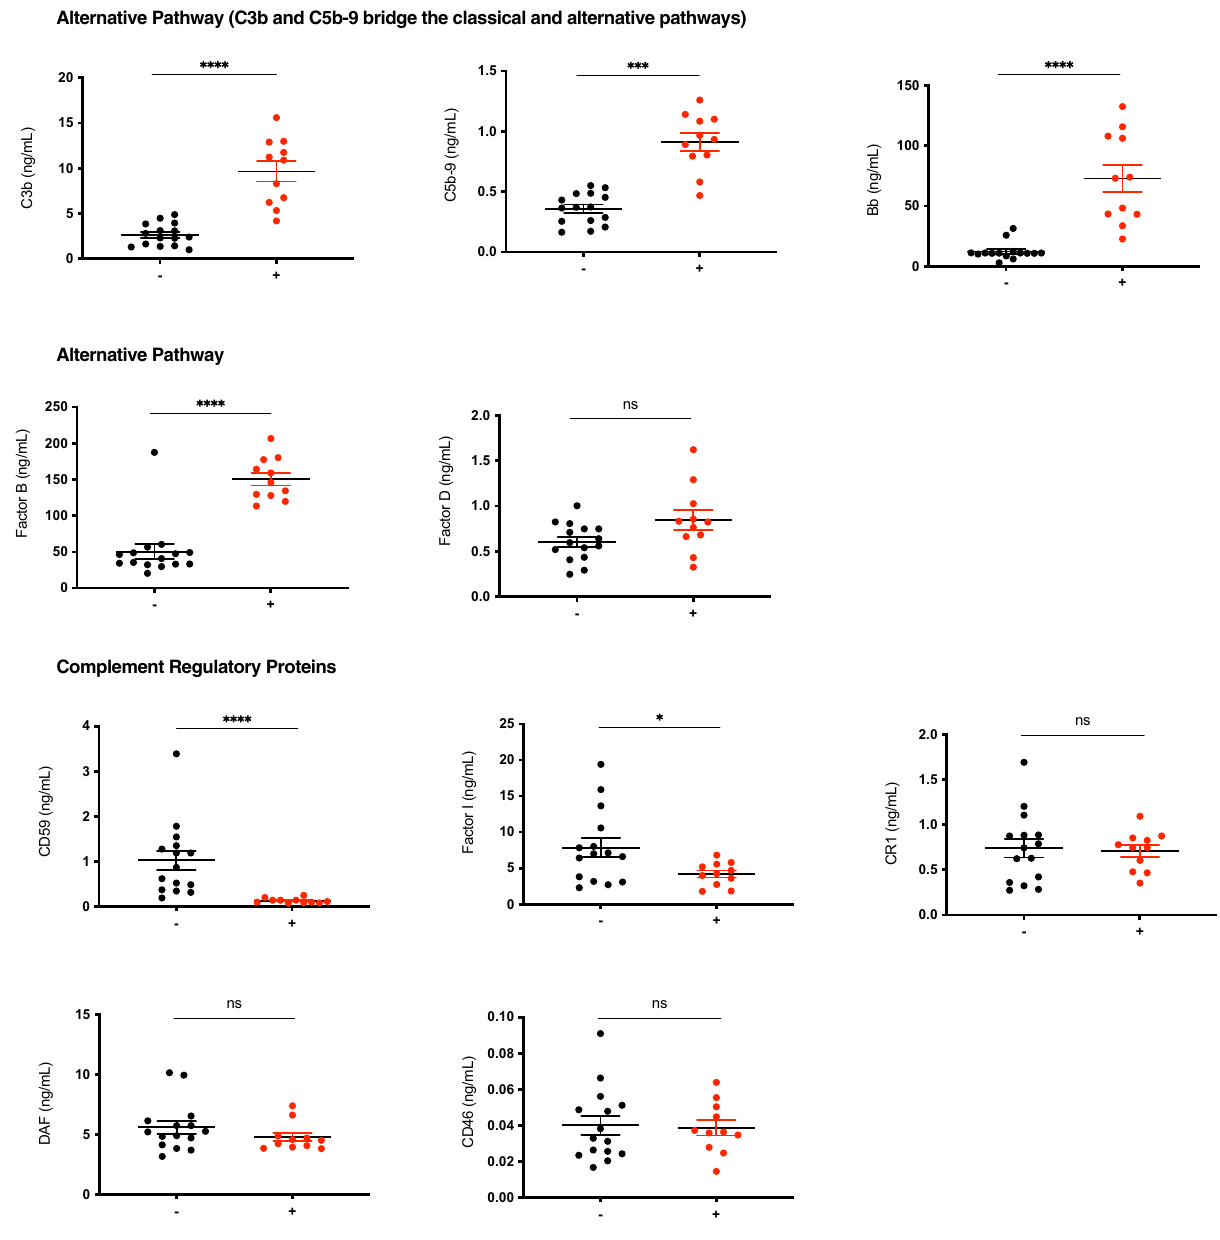
Figure 2. Group comparison of EDE cargo in group of subjects with WMH ( +) versus without (−). Complement factors are grouped by pathway. C3b and C5b-9 grouped under alternative pathway are, as depicted in Supplemental Fig. S1, shared across classical, and alternative pathways. Stars depict significance levels from ANCOVA models, controlling for age, detailed in Table 1: ≤ 0.0001 = ****; ≤ 0.001 = ***; ≤ 0.01 = **; ≤ 0.05 = *; ≥ 0.05 =